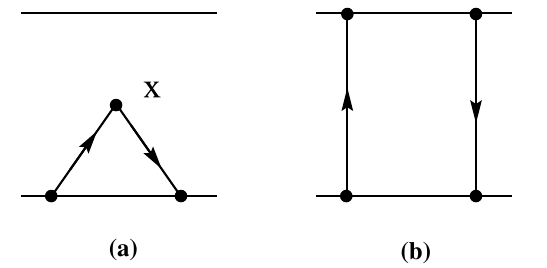
Fig. 1 Sketch of correlation function in the SF: bilinear insertion on the left and boundary-to-boundary on the